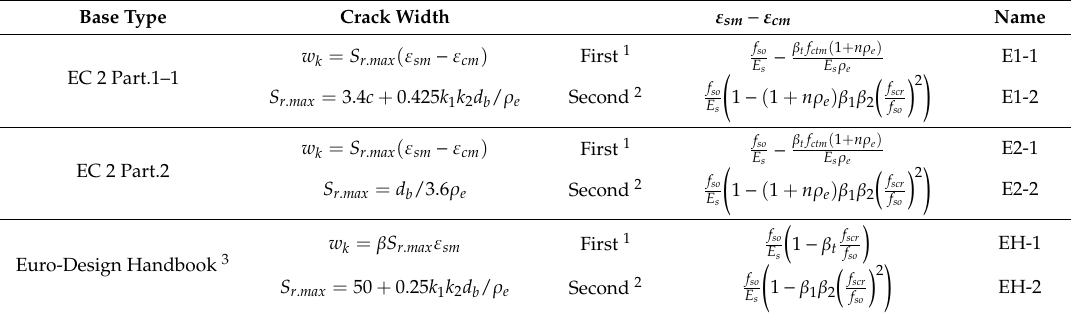
Table 4. Formulas for calculation of the crack